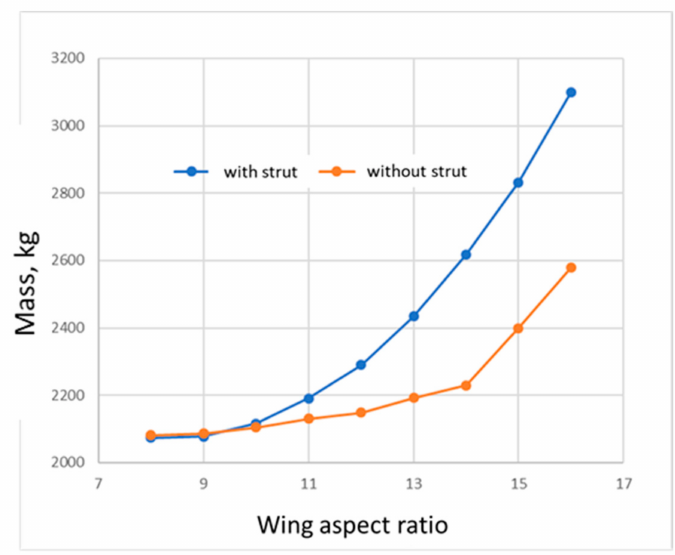
Figure 10. Dependencies of weight of frame of regional aircraft from wing aspect ratio.